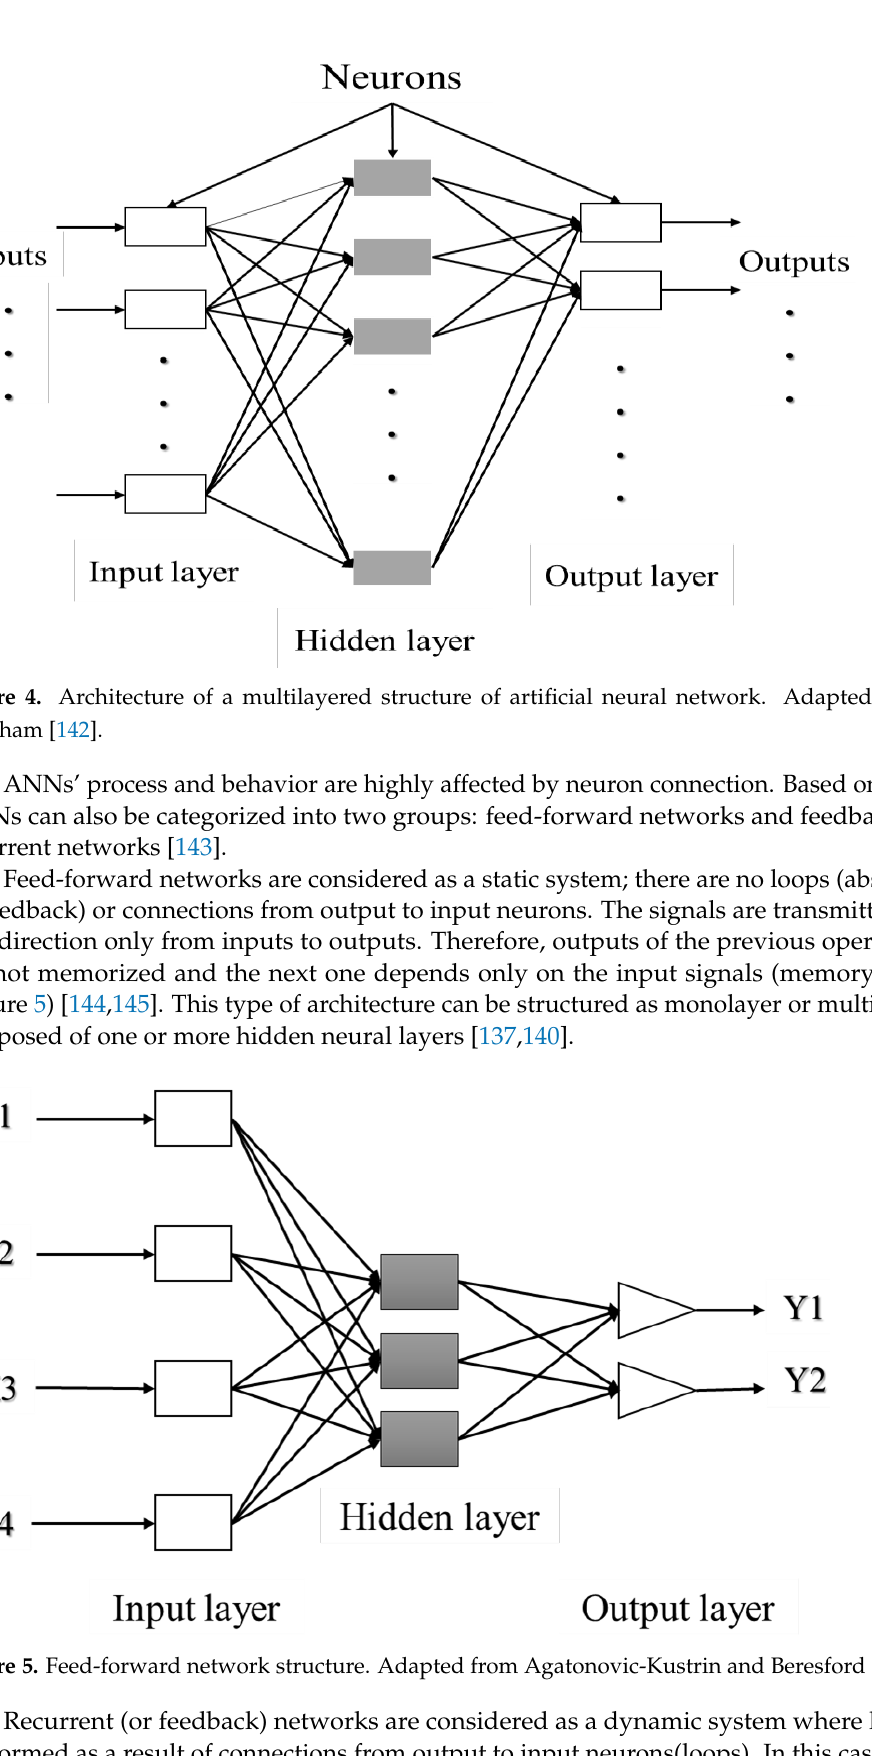
Figure 3. Architecture of a simple artificial neuron. Adapted from Agatonovic-Kustrin and Ber- esford [138] and Abraham [143].